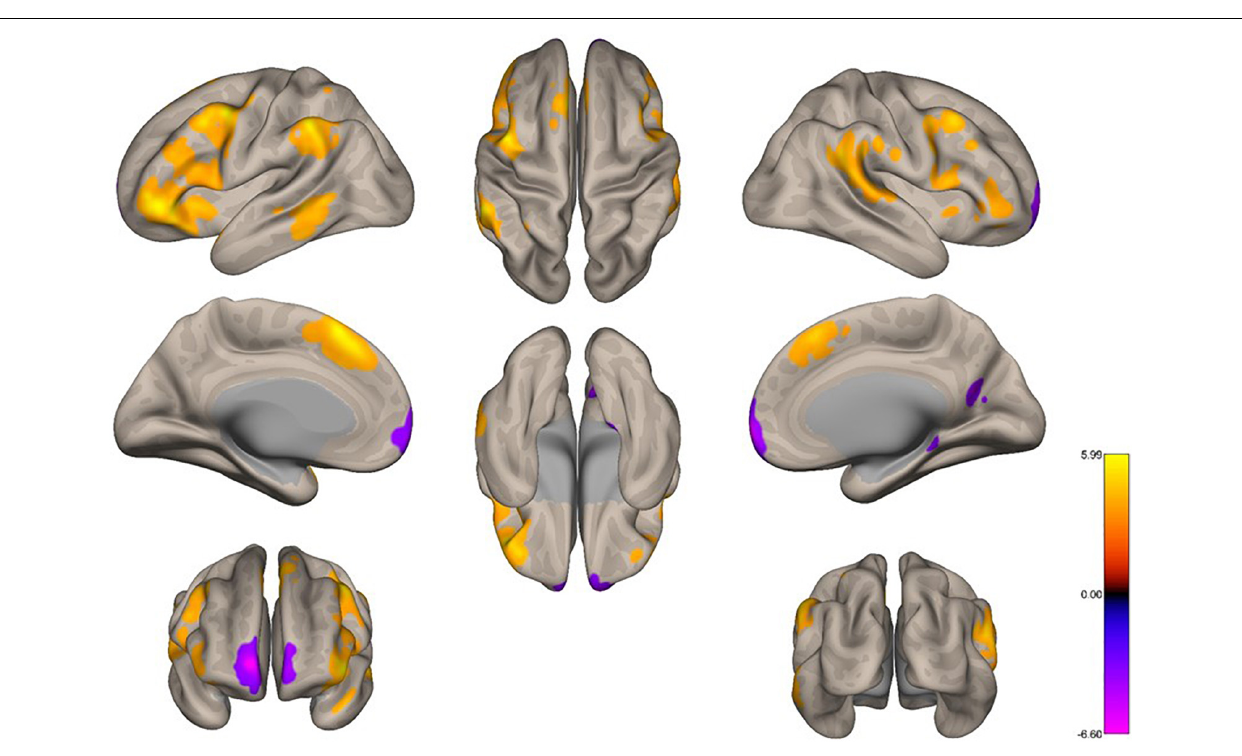
FIGURE 2 | Voxel-level changes in the functional connectivity of the precuneus between the task condition and the resting condition. We applied a height threshold of p < 0.001 (uncorrected) to individual voxels for defining clusters. Subsequently, the significance level for the extracted clusters was set to p -FWE <